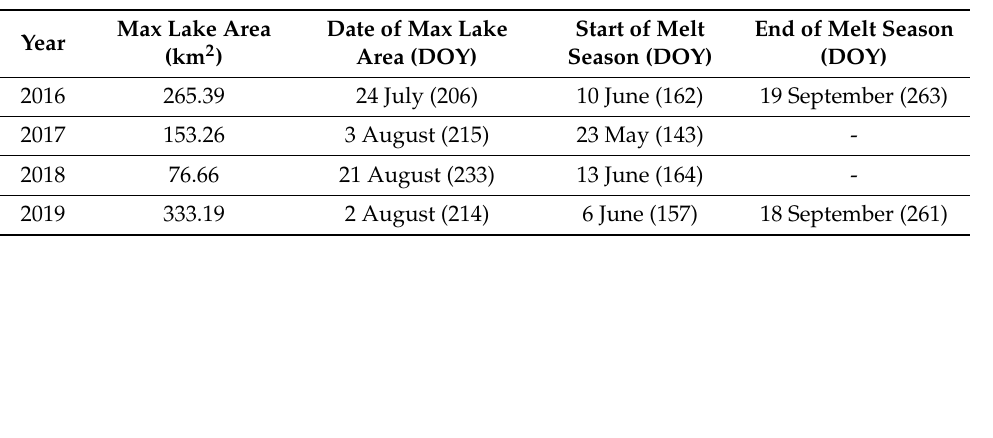
Table 3. Lake area characteristics per year. If there is still > 1 km 2 of lake area at the end of the sensing period, the melt season end cannot be determined